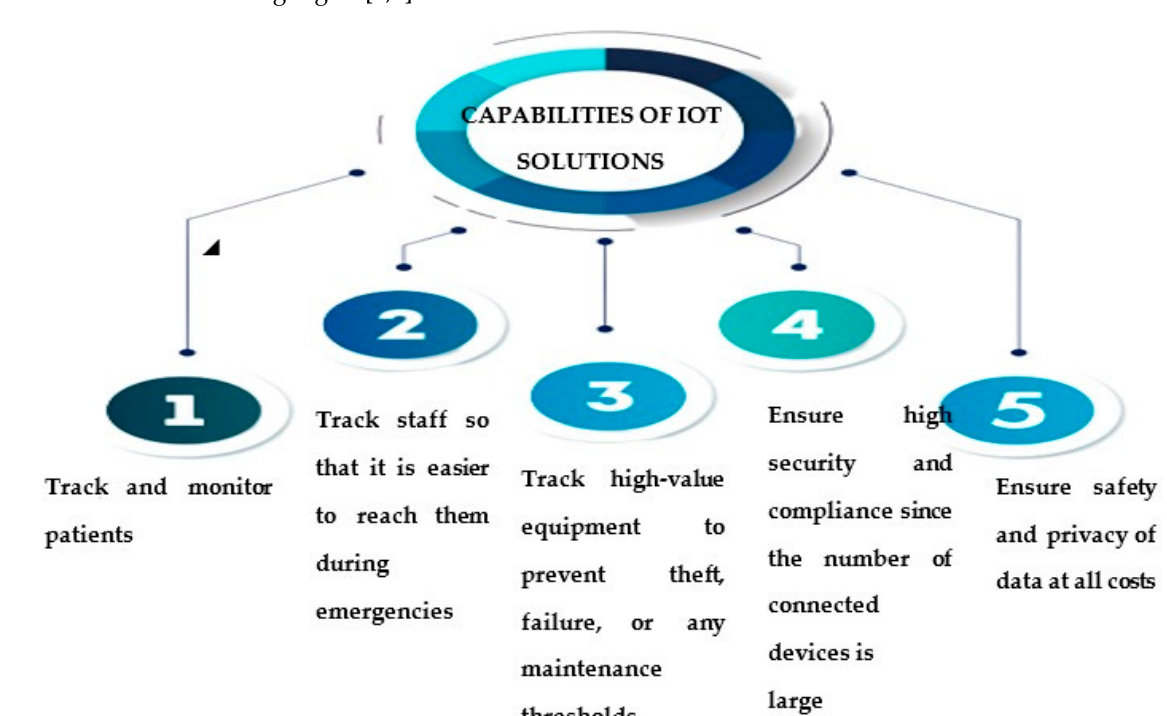
Figure 1. Solutions for the IoT in the medical field .